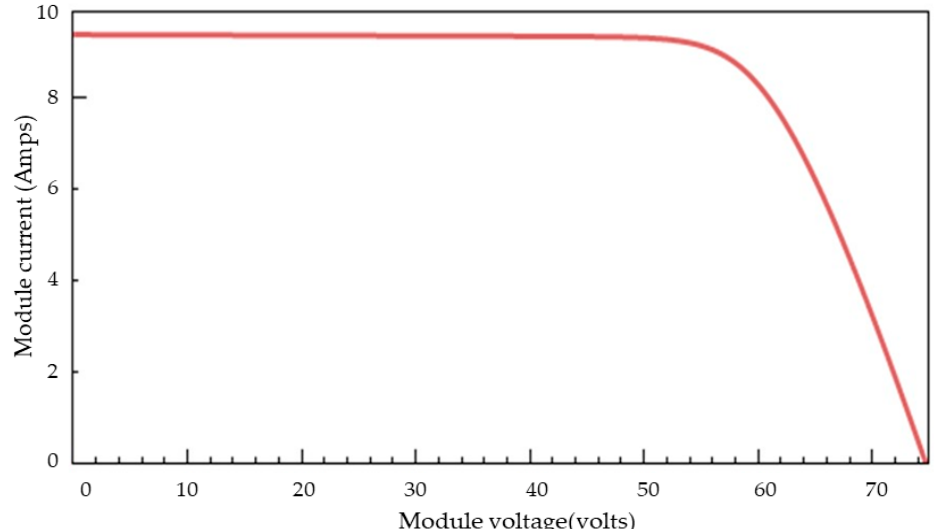
Figure 6. Solar cell current vs. voltage.